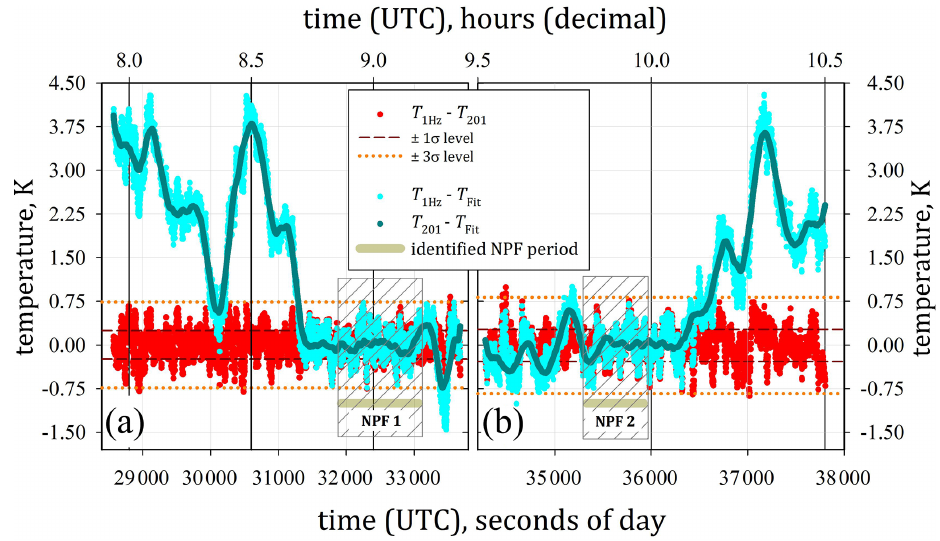
Figure B1. For the time intervals shown in Fig. 14, the difference between the 1Hz data ( T 1Hz ) and the filtered data with 201s running average ( T 201 ) reveals the high-frequency noise of the temperature measurement (red data points). The dashed reference lines indicate the standard deviation ( ± 1 σ and ± 3 σ ) of the noise signal within given time intervals. The effectiveness of the wave fit approximation to the filtered data set during the NPF periods is represented by the difference T 201 − T Fit . During NPF this deviation is small, while away from NPF the wave fit increasingly deviates from the temperature measurement. The deviation of the overlaid wave fit from the untreated 1Hz signal is shown with the differences T 1Hz − T Fit ; during NPF mainly the noise signal remains.